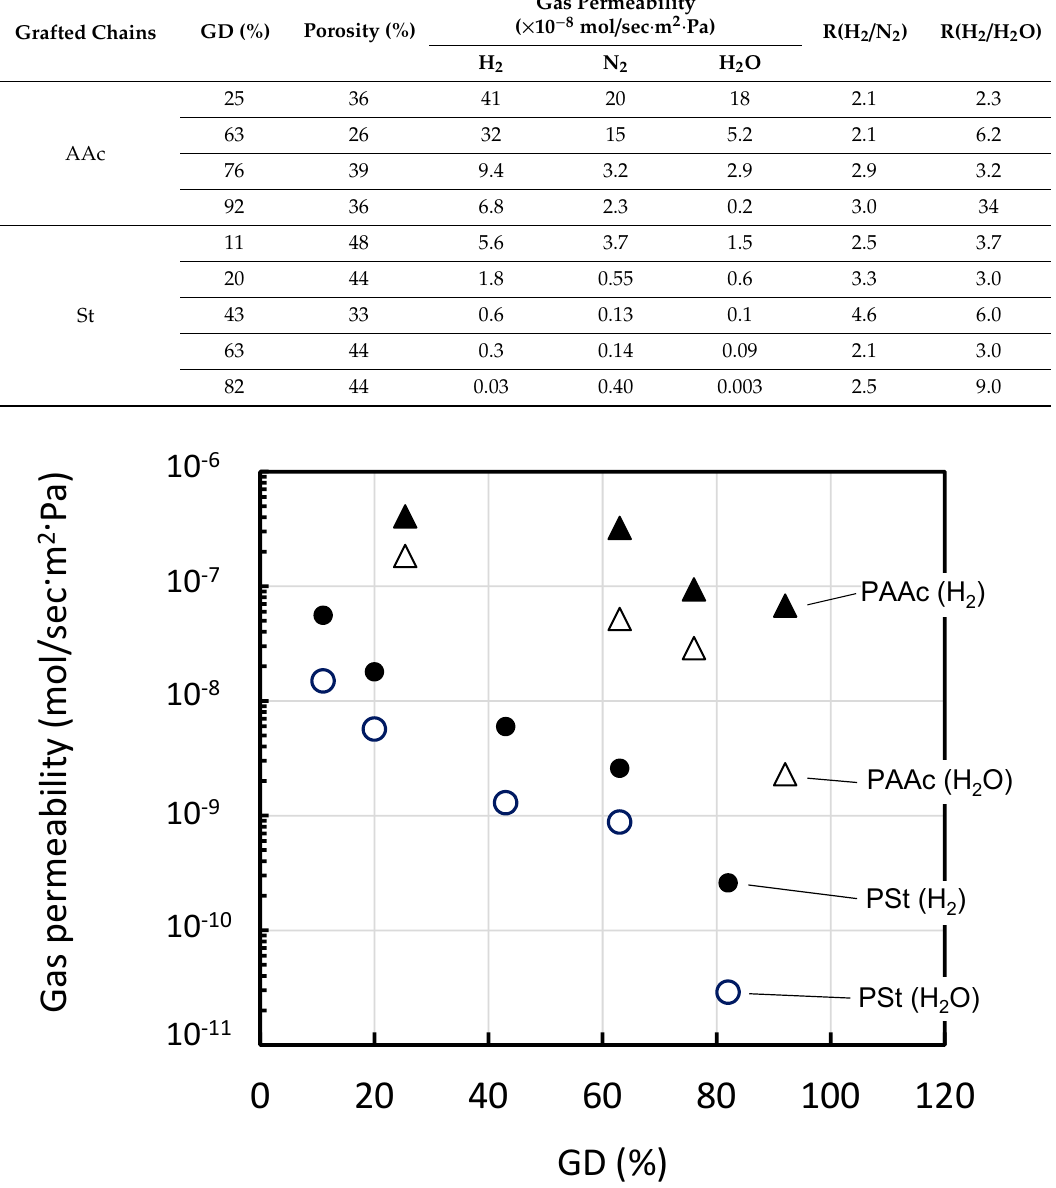
Figure 2. The gas permeability (mol / sec · m 2 · Pa) of H 2 and H 2 O as a function of GD at 95 ◦ C. AAc-grafted PVDF: ( ▲ ) H 2 , ( △ ) H 2 O. St grafted PVDF: ( ● ) H 2 , ( ○ ) H 2 O. Table 2. H 2 /N 2 (O 2 model) and H 2 /H 2 O ratios through the St- and AAc-grafted PVDF membranes. Grafted